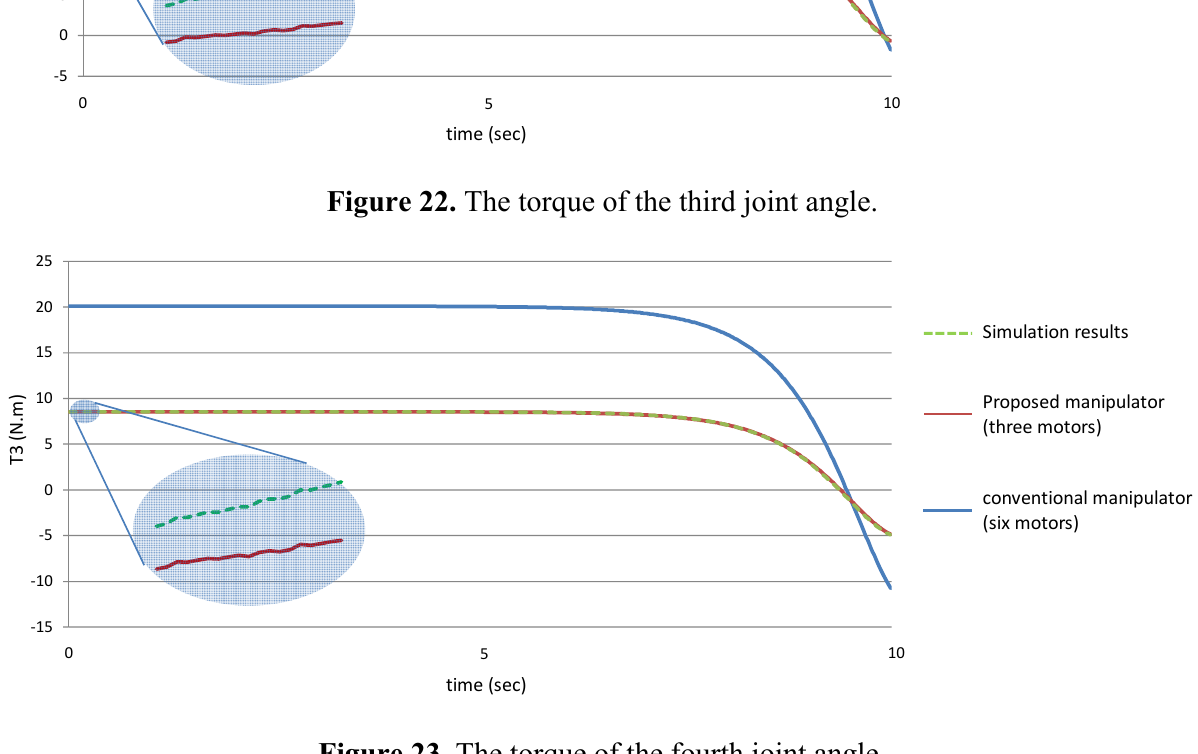
Figure 23. The torque of the fourth joint